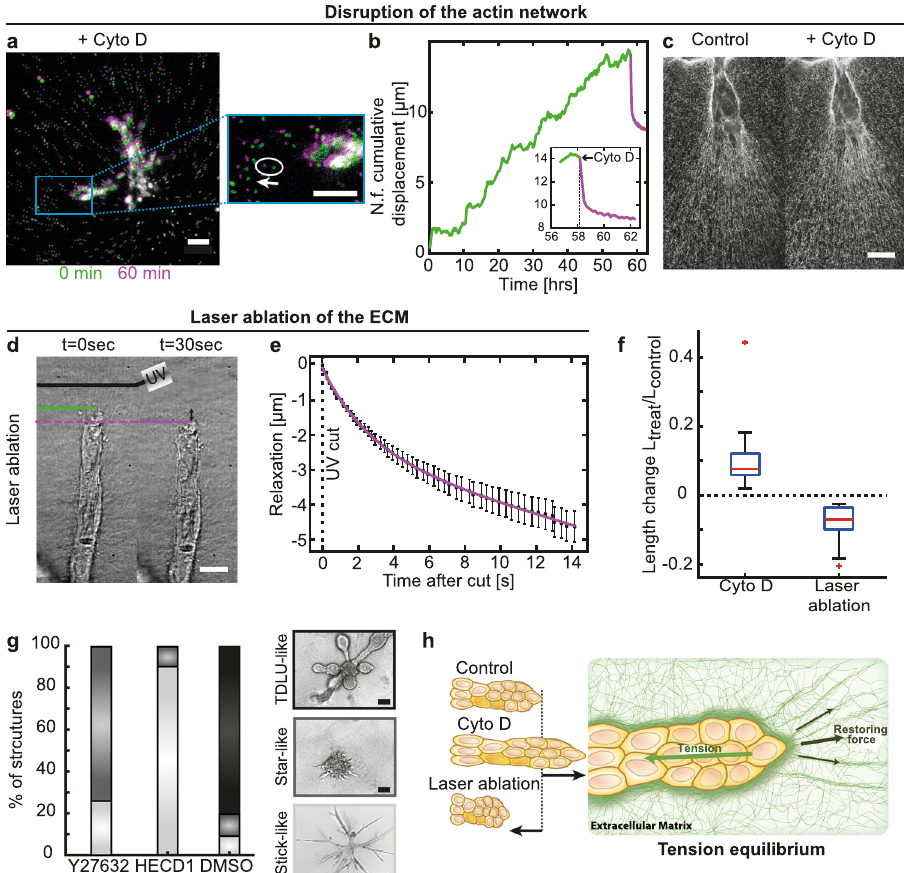
Fig. 3 ECM deformations are enabled through a tension equilibrium. a Upon treatment with Cytochalasin D organoid branches relax. Beads retract in the opposite direction of the initial deformation fi eld (white arrow, n = 31 organoids). b Representative behavior of cumulative displacement in front of the branch during branch elongation (green) and relaxation upon treatment with Cytochalasin D (1 µ g/ml, purple). c Fiber alignment in front of the branch is conserved after treatment with Cytochalasin D. d UV-cuts of the ECM in front of growing branches and following contraction of the branches towards the organoid body ( n = 121 organoids). e Tracking the tip of a branch after a cut reveals a fast contraction towards the organoid body. Error bars, mean ± s.d. f After disruption of the actin network via Cytochalasin D the restoring forces of the ECM dominate, leading to branch elongation ( n = 31 organoids). Contrary, after laser ablation, the dominating tension of the branch leads to branch shrinkage ( n = 21 organoids). Box plots indicate median (red line), 25th, 75th percentile (blue box) and 5th and 95th percentile (whiskers) as well as outliers (single points). g Drug screening reveals loss of potential to grow TDLU-like structures upon Y-27632 ( n = 31 organoids) and HECD1 ( n = 10 organoids) treatment. h Tensile forces of the branches and the restoring forces of the aligned ECM lead to a tension equilibrium stabilizing the branches. Scale bars, 50 µ m ( a , inset a ), 20 µ m ( c ), 15 µ m ( d ). Organoids were derived from three biologically independent donors (Supplementary Table S1). Source data are provided as a Source Data fi